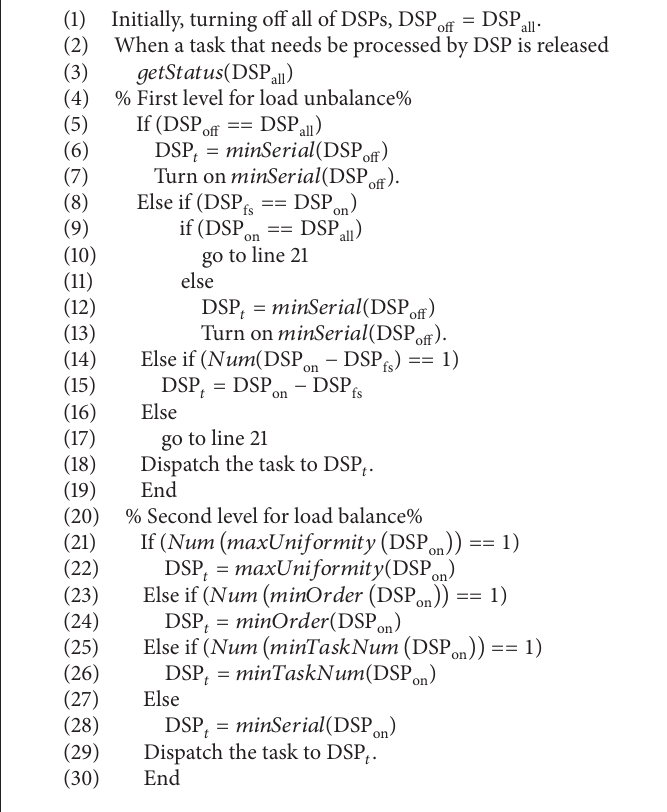
Pseudocode 2: Pseudocode of two levels deadline-aware hybrid load